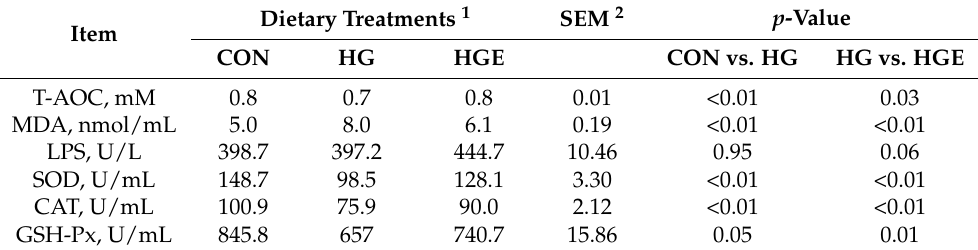
Table 3. Effects of vitamin E on milk’s antioxidant capacity induced by high concentration in subacute ruminal acidosis